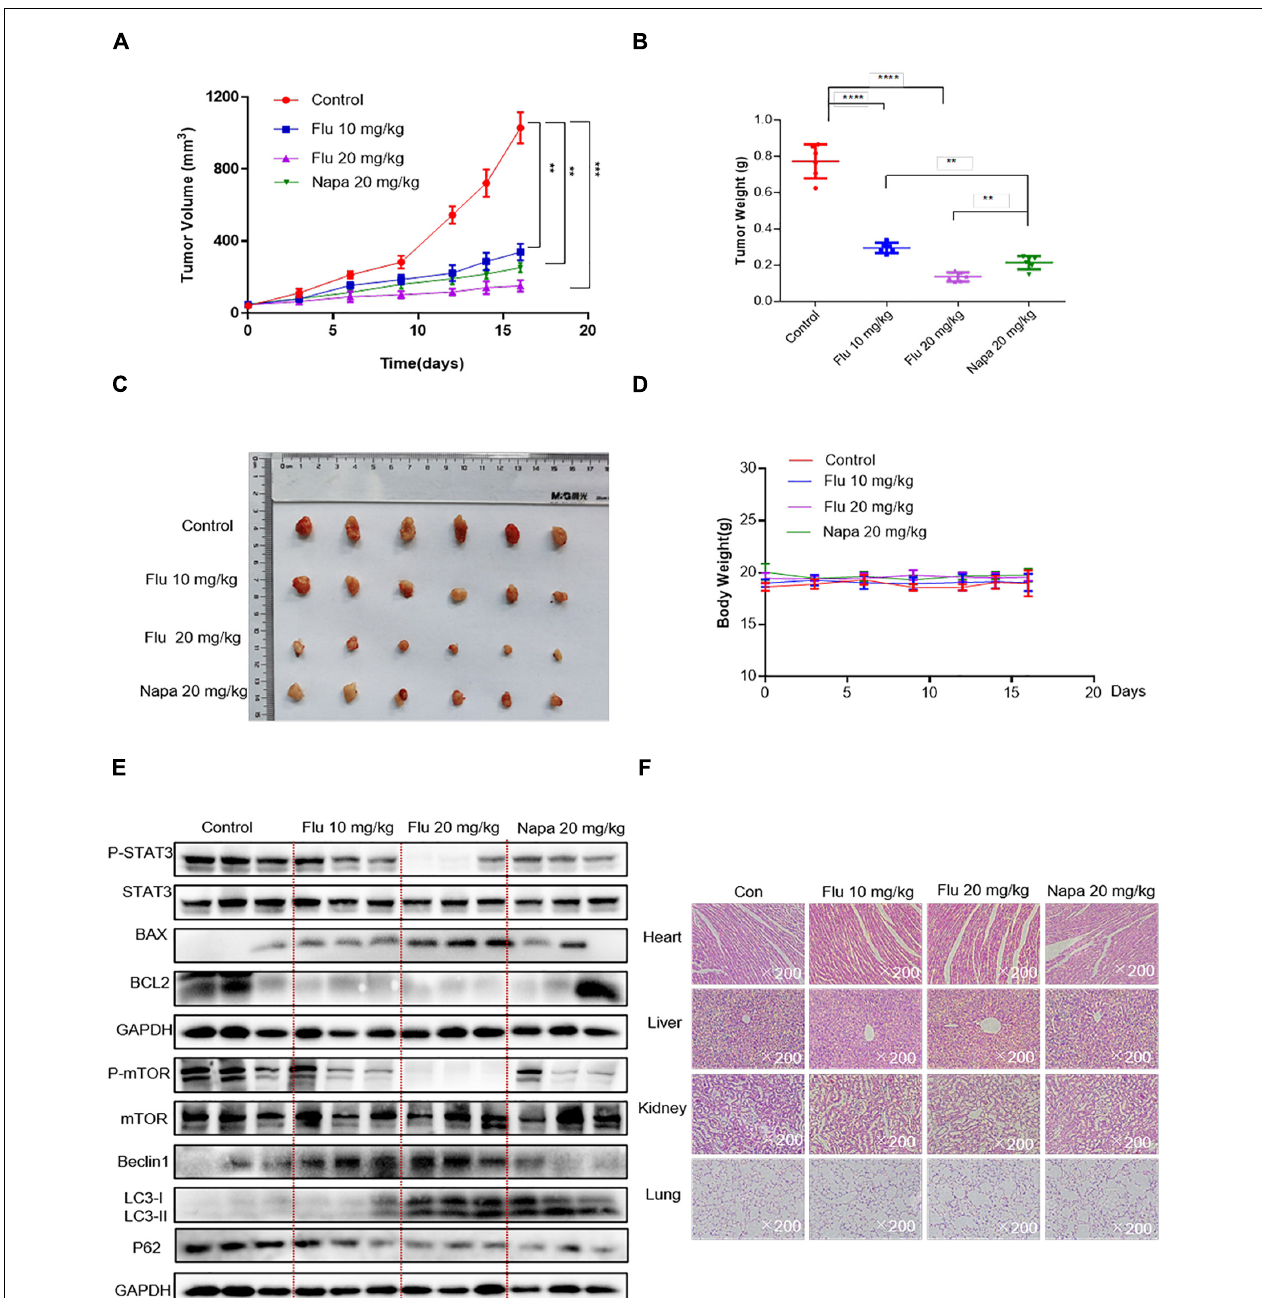
FIGURE 6 | Flubendazole inhibited the growth of NSCLC tumor xenografts. (A) Tumor volumes. (B) Measurement of tumor weights. (C) Representative figures of the tumor tissue in the flubendazole-administered and control groups ( n = 6). (D) Body weight of mice. (E) Representative blots indicating the expressions of p-STAT3, BAX, BCL-2 and p-mTOR, Beclin-1, and LC3 in tumor tissues. (F) Hematoxylin and eosin staining of the heart, liver, lung, and kidney tissues from nude mice at × 200 magnification. The images shown are representative of three separate experiments (** P < 0.01, *** P < 0.001, **** P <